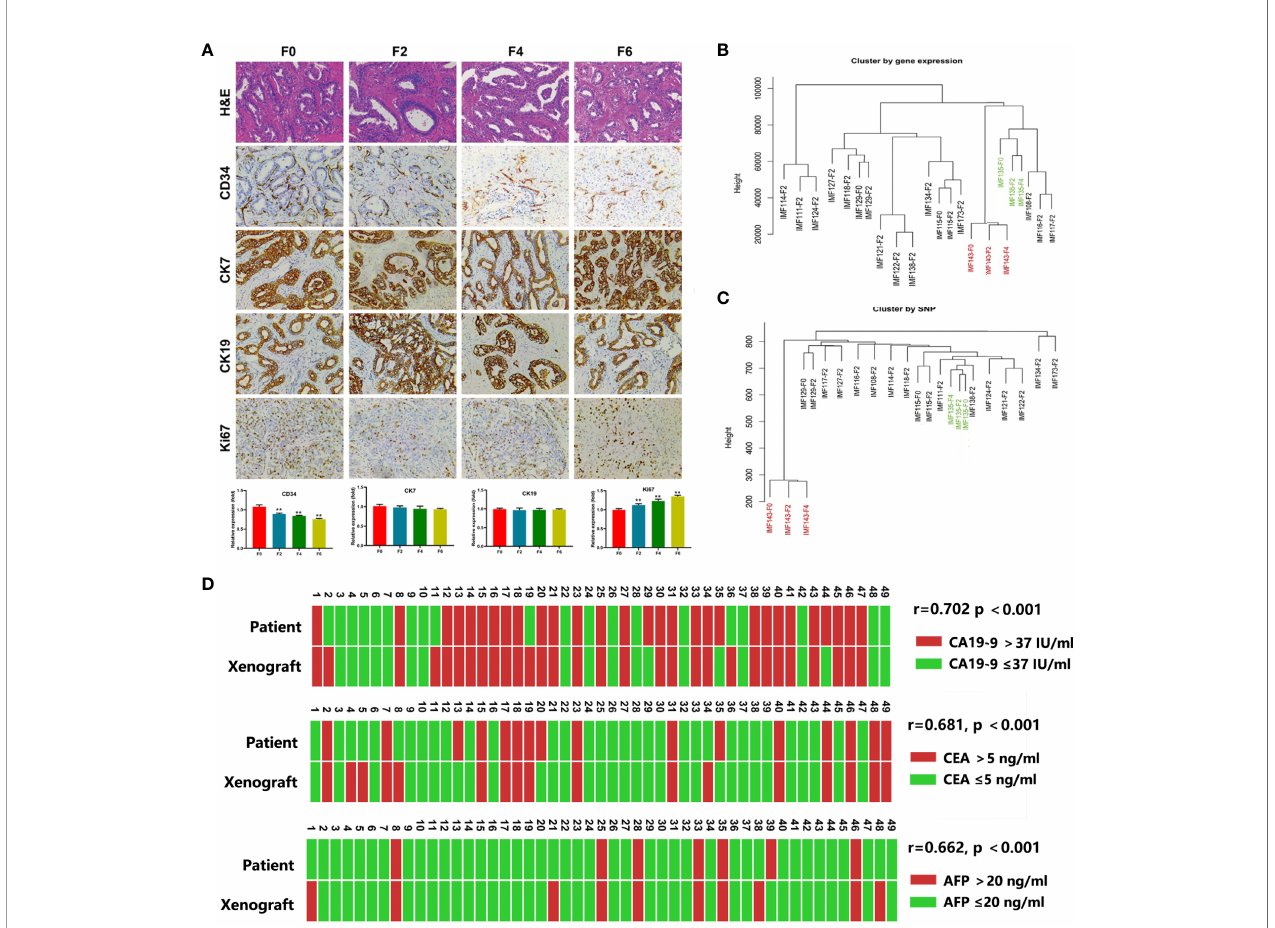
FIGURE 1 | The PDX models recapitulated the characteristics of the parental tumors. (A) Representative H&E sections and immunohistochemical pro fi les of CD34, CK7, CK19 and Ki67 in serial PDXs and their parental primary tumors (200×). F0, primary tumor; F2, the second passaged xenograft in mice; F4 and F6, the fourth and sixth passaged xenograft; **P < 0.01 (B, C) , The dendograms showed unsupervised clustering of samples according to gene expression pattern by Human Genome U133 Plus 2.0 Array (B) and SNP by SNP 6.0 arrays (C) ; (D) Comparison of serum CA19-9, CEA and AFP in PDX models and corresponding